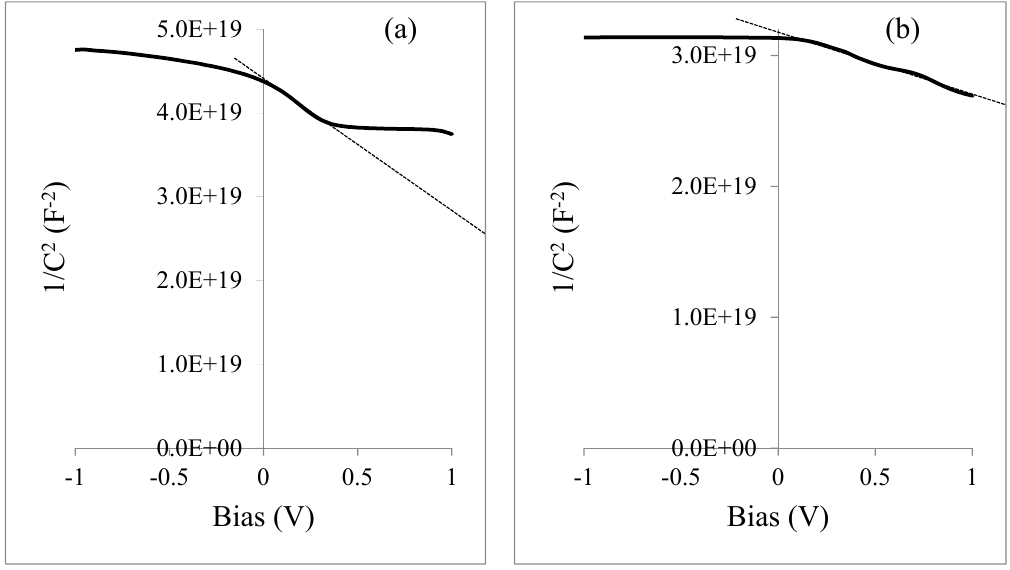
Figure 11. Dark 1/ C 2 vs. V plots at 1 MHz for ( a ) glass/FTO/ZnS/CdS/CdTe/Au 3-layer device and ( b ) glass/FTO/CdS/CdTe/Au 2-layer device as a function of DC bias